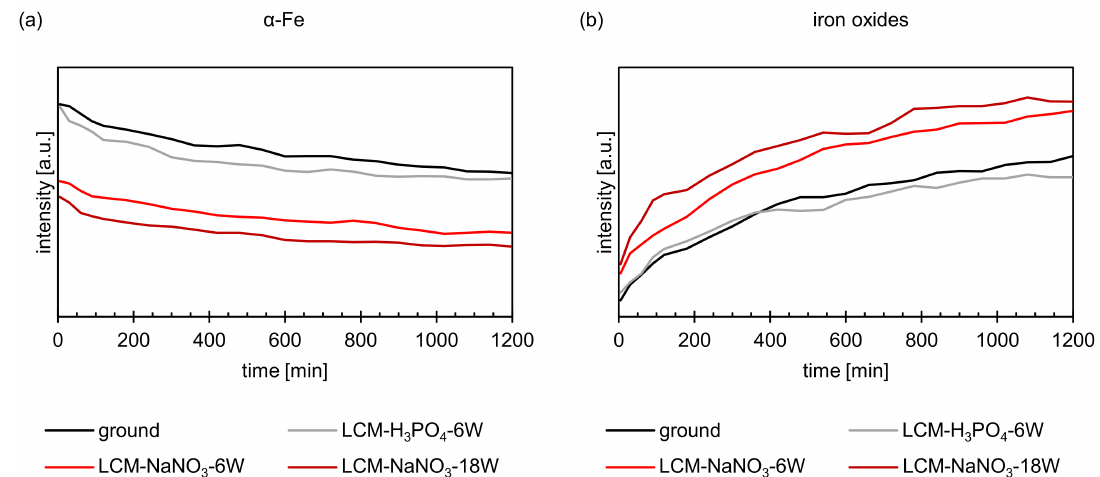
Figure 8. XRD intensities of ( a ) α -Fe and ( b ) iron oxides during oxidation at 500 ◦ C up to 20 h. SEM investigations revealed significant differences between ground and LCM-H 3 PO 4 -6W 42CrMo4 steel compared to LCM-NaNO 3 -6W and LCM-NaNO 3 -18W after oxidation at 500 ◦ C for 20 h. SEM top-view images (Figure 9a,b) show the formation of whisker-like structure on the ground surfaces and the surfaces machined in H 3 PO 4 . In contrast, no whiskers but plate-like structures are present on both LCM-NaNO 3 surfaces, as shown in Figure 9c,d.